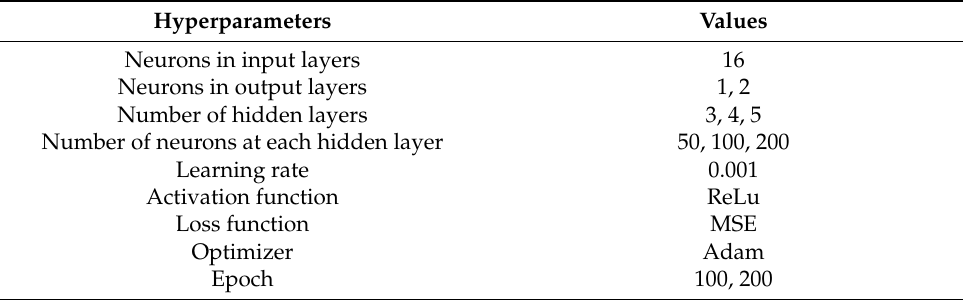
Table 7. Range of the hyperparameters used in DNN models in this study.